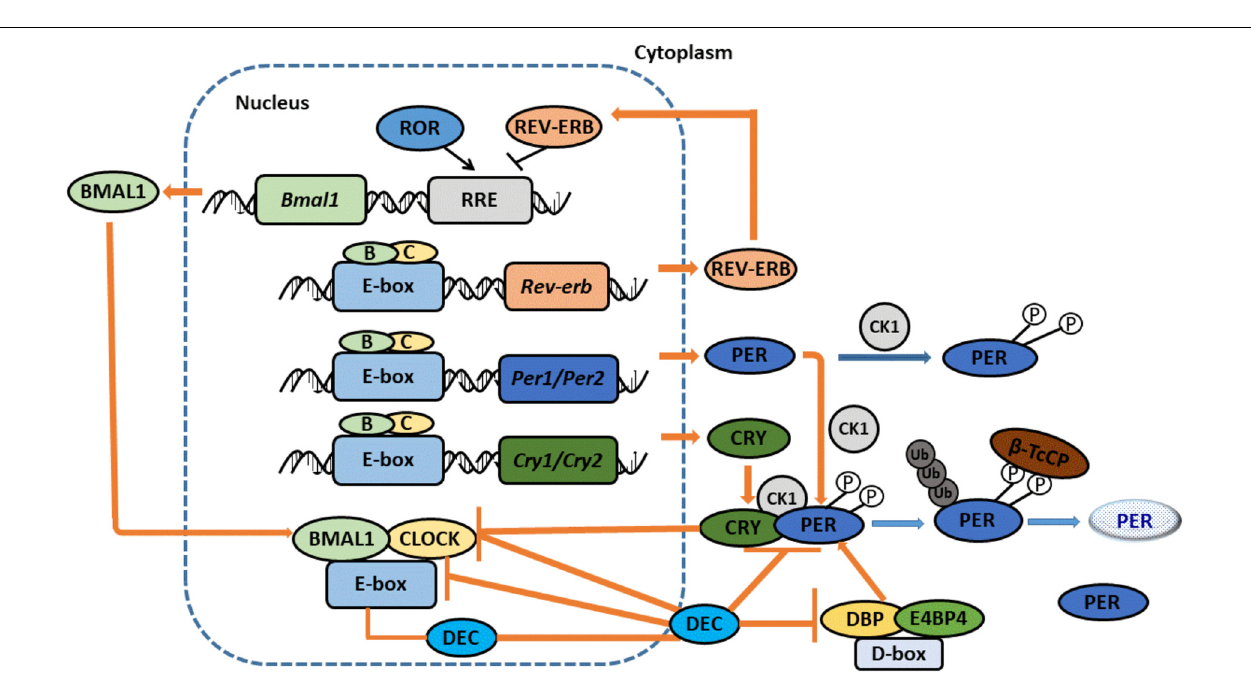
FIGURE 1 | Multiple metabolic disorders involved in the pathogenesis of hepatic steatosis. Hepatic steatosis can be stimulated via increased adipose tissue lipolysis, increased de novo lipogenesis, increased dietary fatty acid uptake, impaired β -oxidation, and reduced VLDL synthesis and secretion. Insulin resistance is particularly involved in several metabolic pathways. These all lead to hepatic triglyceride accumulation and ultimately NAFLD.